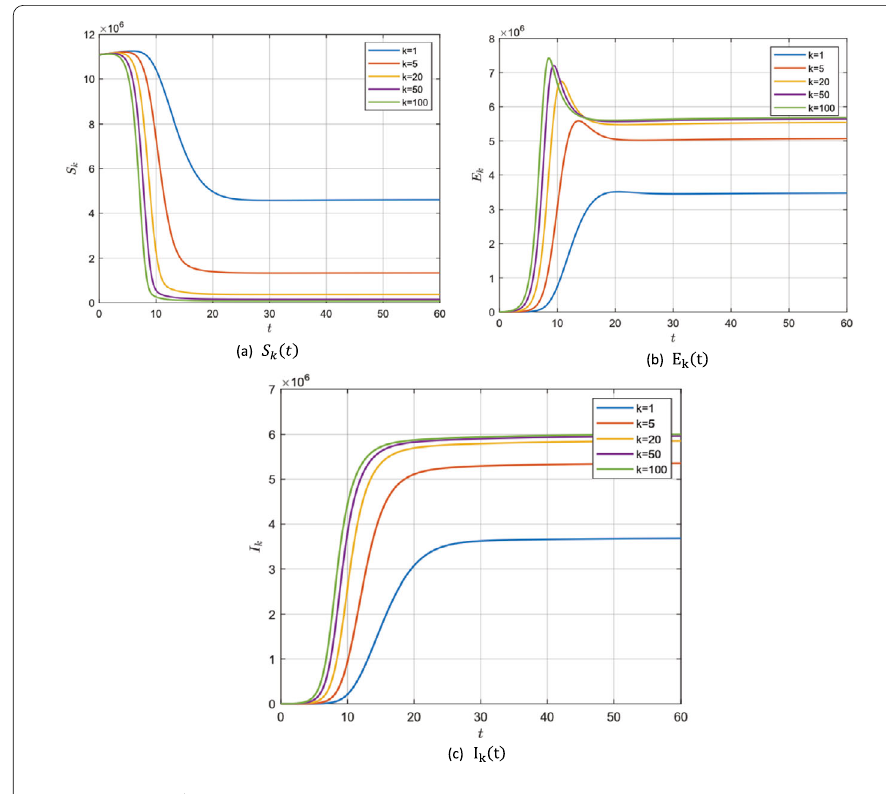
Figure 7 α = 1 and R 0 = 22.1121